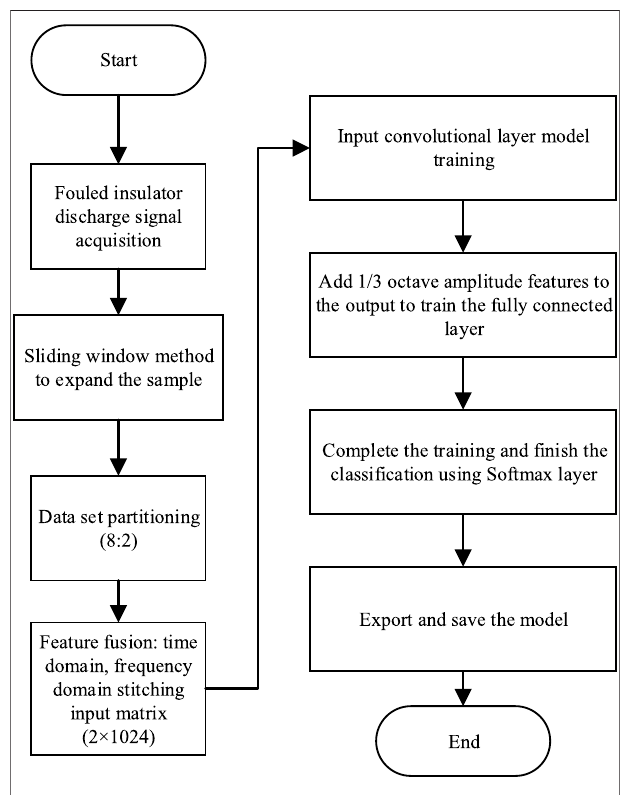
FIGURE 1 | Fouled insulator discharge mode monitoring process.